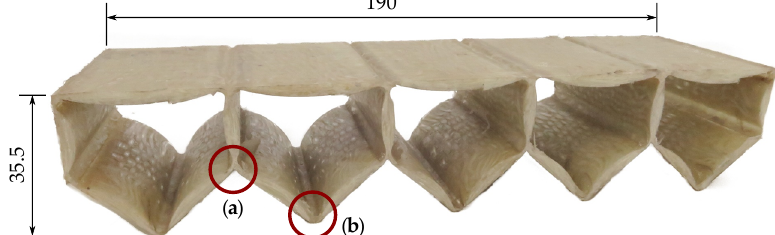
Figure 19. Woven fiber reinforced plastics (FRP)-PACS Cantilever: ( a ) Crossover area. ( b ) Single hinge